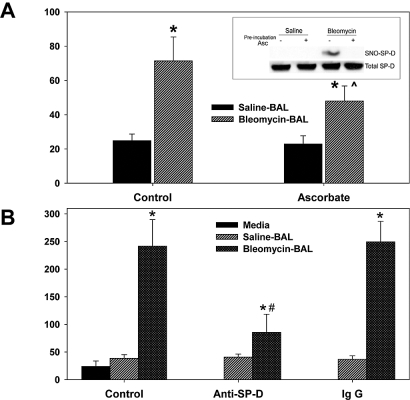
BAL from Bleomycin-Treated Rats Induces Macrophage Chemotaxis in Part through SNO-SP-D(A) BAL from bleomycin- and saline-treated rats were analyzed for their ability to induce RAW cell chemotaxis. Bleomycin BAL induced chemotaxis to a greater extent than saline BAL; however, pretreatment with ascorbate to remove SNO abrogated this response. The effect of ascorbate treatment on BAL SNO-SP-D content is shown in the inset where samples were analyzed by biotin-switch.(B) The importance of SP-D in this SNO-mediated increase is demonstrated by effect of SP-D immunoprecipitation. Bleomycin and saline BAL were analyzed for chemotactic effect following pretreatment with anti-SP-D or non-immune IgG. Only anti-SP-D pre-treatement reduced the increase in chemotaxis induced following bleomycin administration. (asterisk represents significantly different from saline-BAL; # represents significantly different from control or IgG; p < 0.05)